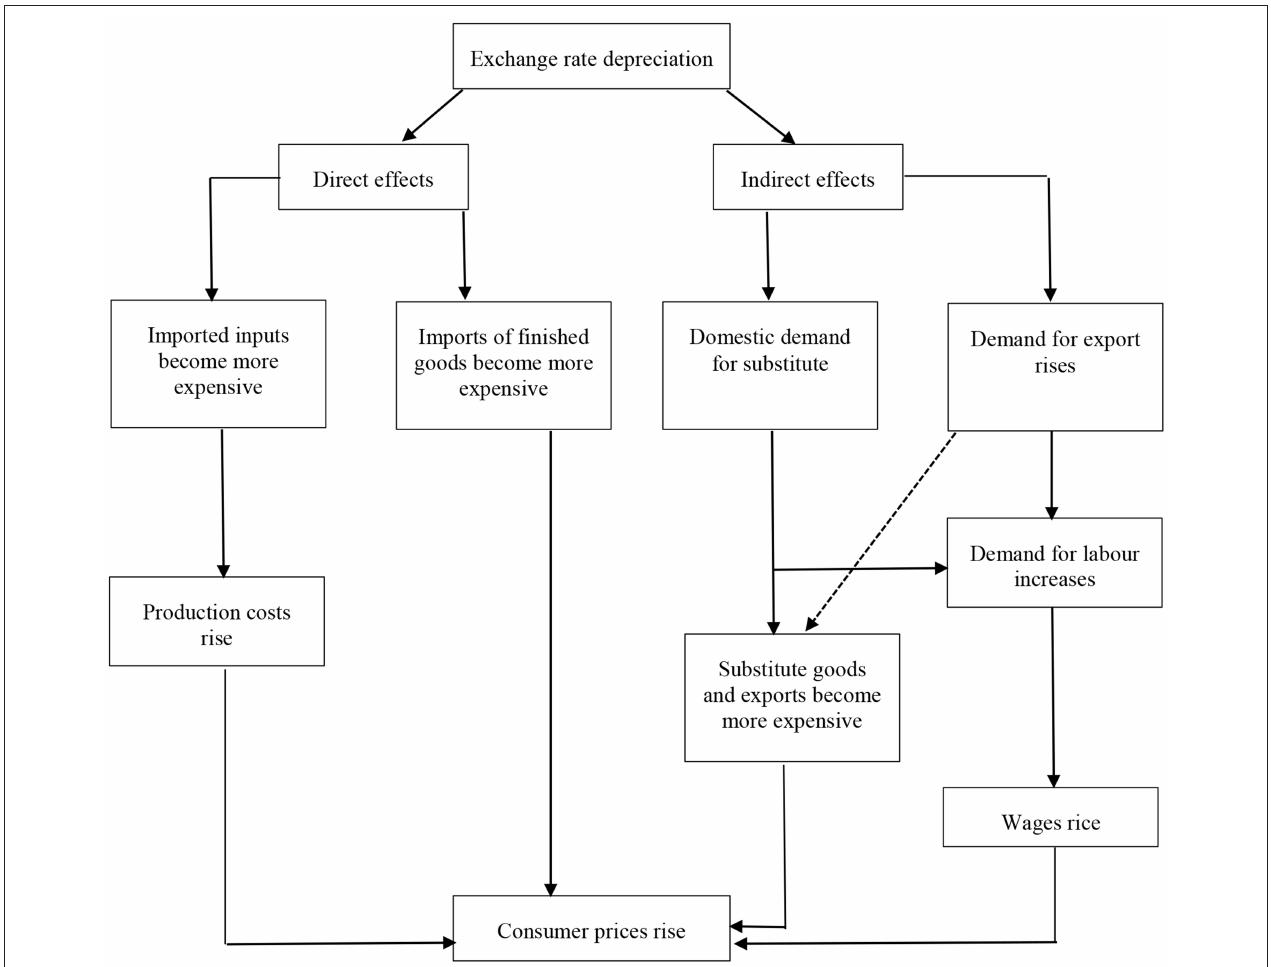
FIGURE 1 | Mechanism of pass-through. Source: Schröder and Hüfner [4], p. 4.